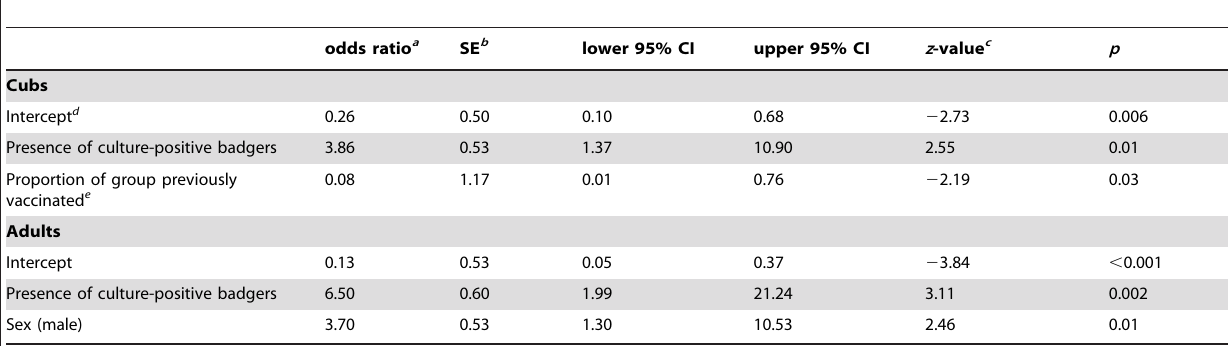
Table 2. Factors affecting the likelihood of unvaccinated badgers in vaccinate groups testing positive to any of the following diagnostic tests: IGRA (PPDB – PPDA); Stat-Pak;